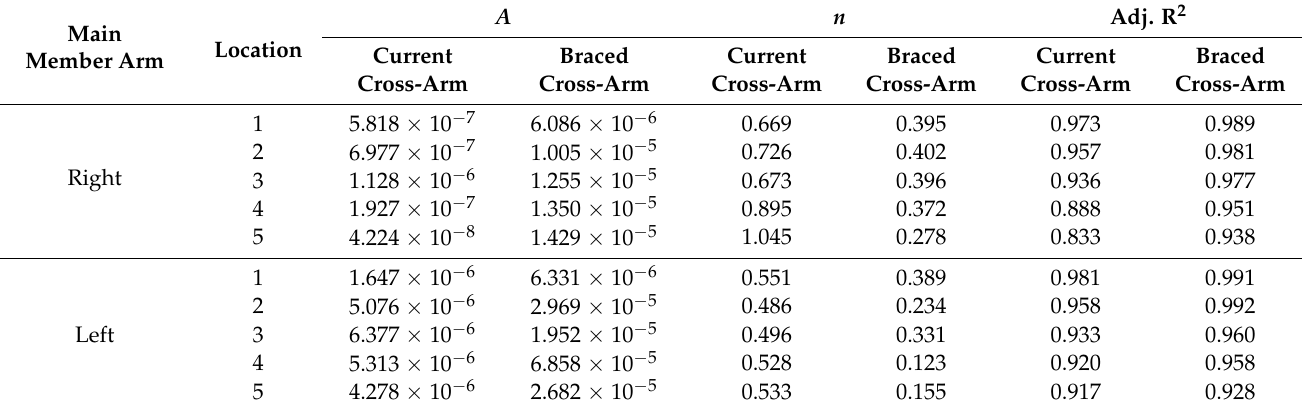
Table 2. Average parameters obtained from Findley power law for current and braced wooden cross-arms. Main